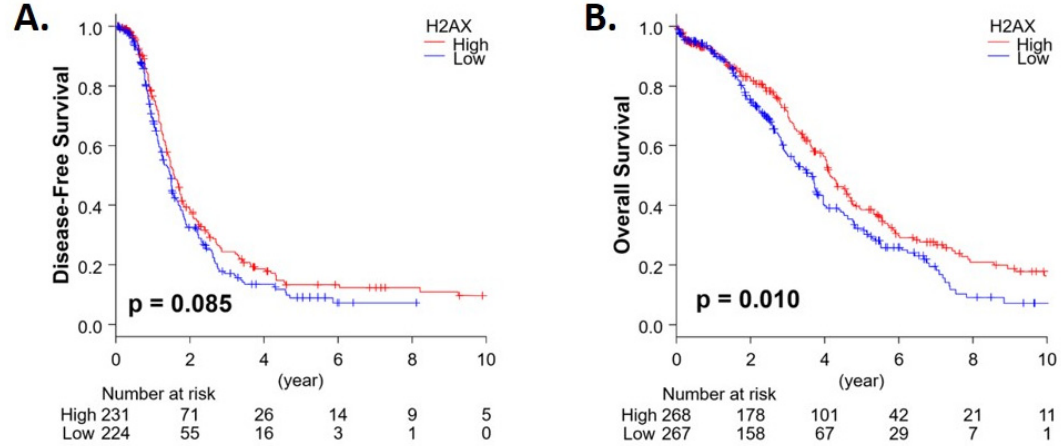
Figure 6. Kaplan–Meier (KM) plots for disease-free survival ( A ) and overall survival ( B ) in OC patients using the TCGA database.